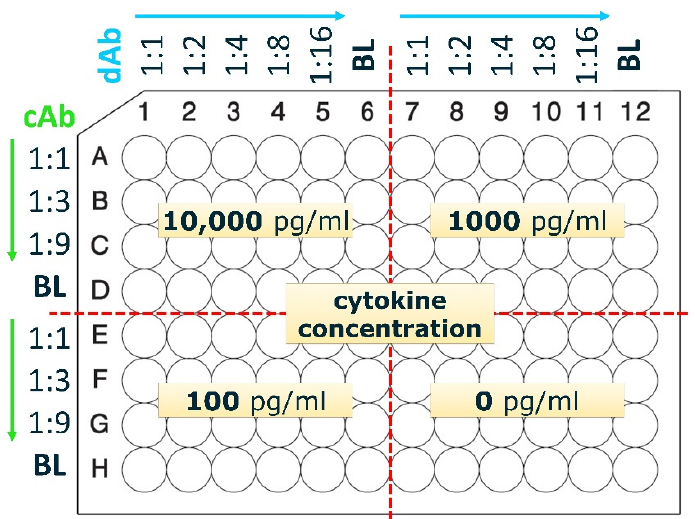
Figure 2. Checkerboard titration plate layout. The capture antibody (cAb) is titrated along rows and the detection antibody (dAb) along columns, as indicated. Rows D and H and columns 6 and 12 are blank (BL) and do not contain antibodies. To each of the 4 quarters of the plate one concentration of cytokine is added (10,000, 1000, 100, or 0 pg/mL). This setup allows to test the combination of multiple cAb and dAb concentrations with cytokines in one go, using one ELISA plate. Starting values (1:1) for antibodies for IL-2, IL-6 and IL-10 was 2.5 µg/mL cAb and 0.2 µg/mL dAb, for IL-12p40 was 2 µg/mL cAb and 0.02 µg/mL dAb, and for IFN- γ was 4 µg/mL cAb and 0.5 µg/mL dAb.